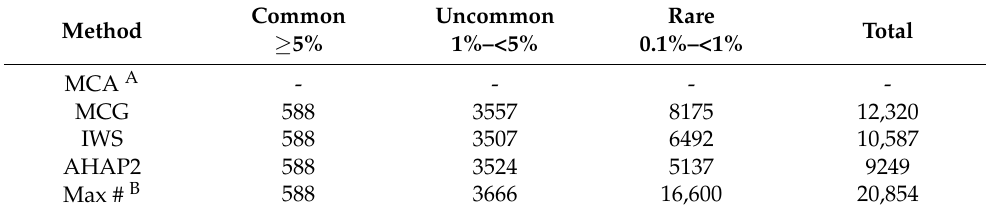
Table 2. Number of unique haplotypes accounted for when 100 animals are selected as whole-genome sequencing candidates using varying methods that utilise a relationship matrix (MCA/MCG) or haplotype library (IWS/AHAP2),